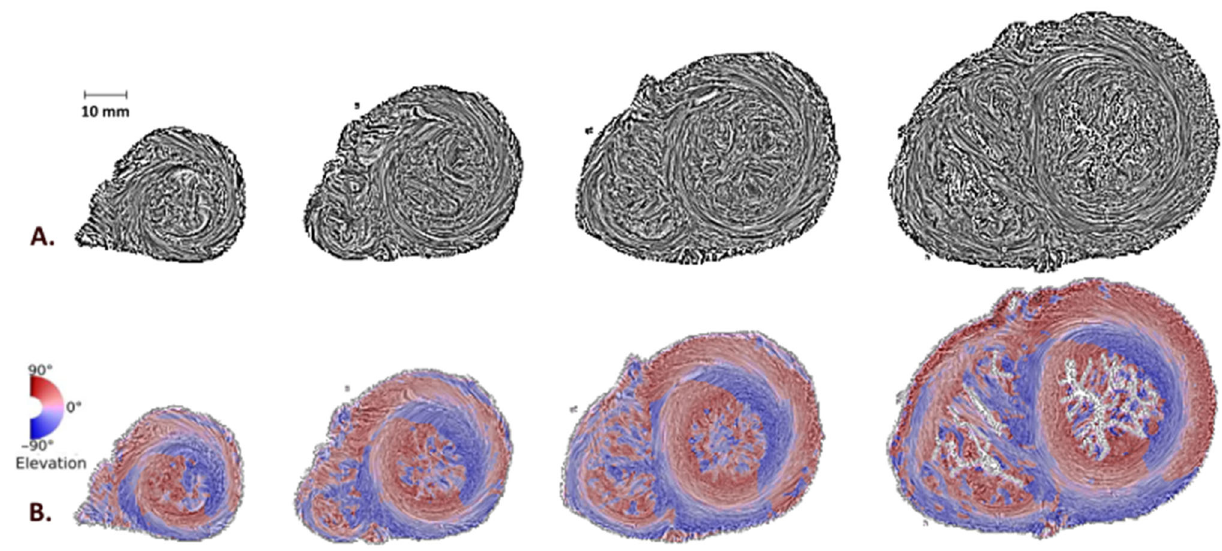
Figure 7. Short-axis sections of a perinatal heart (7 days of life) from the apical to the middle level just under the papillary muscles, using streamline maps with an LIC texture ( A ) or elevation maps ( B ). While the LV apex takes on a vortex shape, this is not the case for the RV apex.